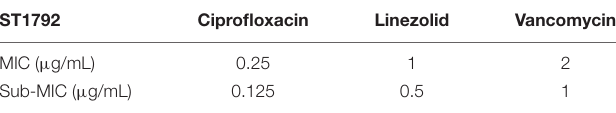
TABLE 4 | Minimum inhibitory concentration (MIC) and sub-MIC for strain ST1792.